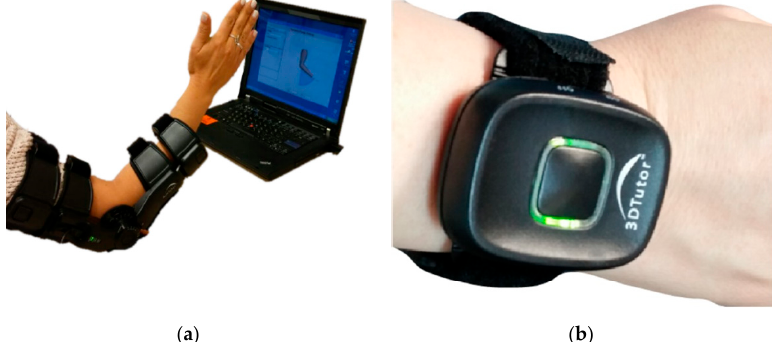
Figure 2. The Meditouch hardware used in this study comprise ( a ) the ArmTutor device, used for exercising elbow flexion and extension, and ( b ) the 3-D device, placed and the wrist and used for exercising supination and pronation.